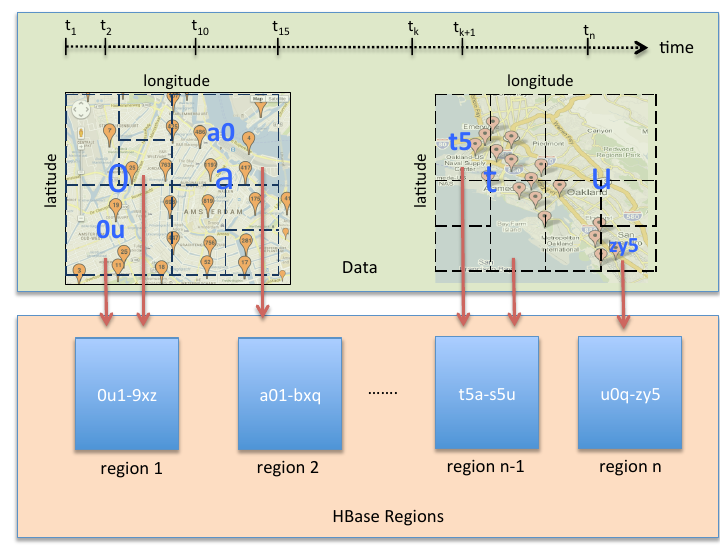
Figure 9. Spatio–temporal data partitioning